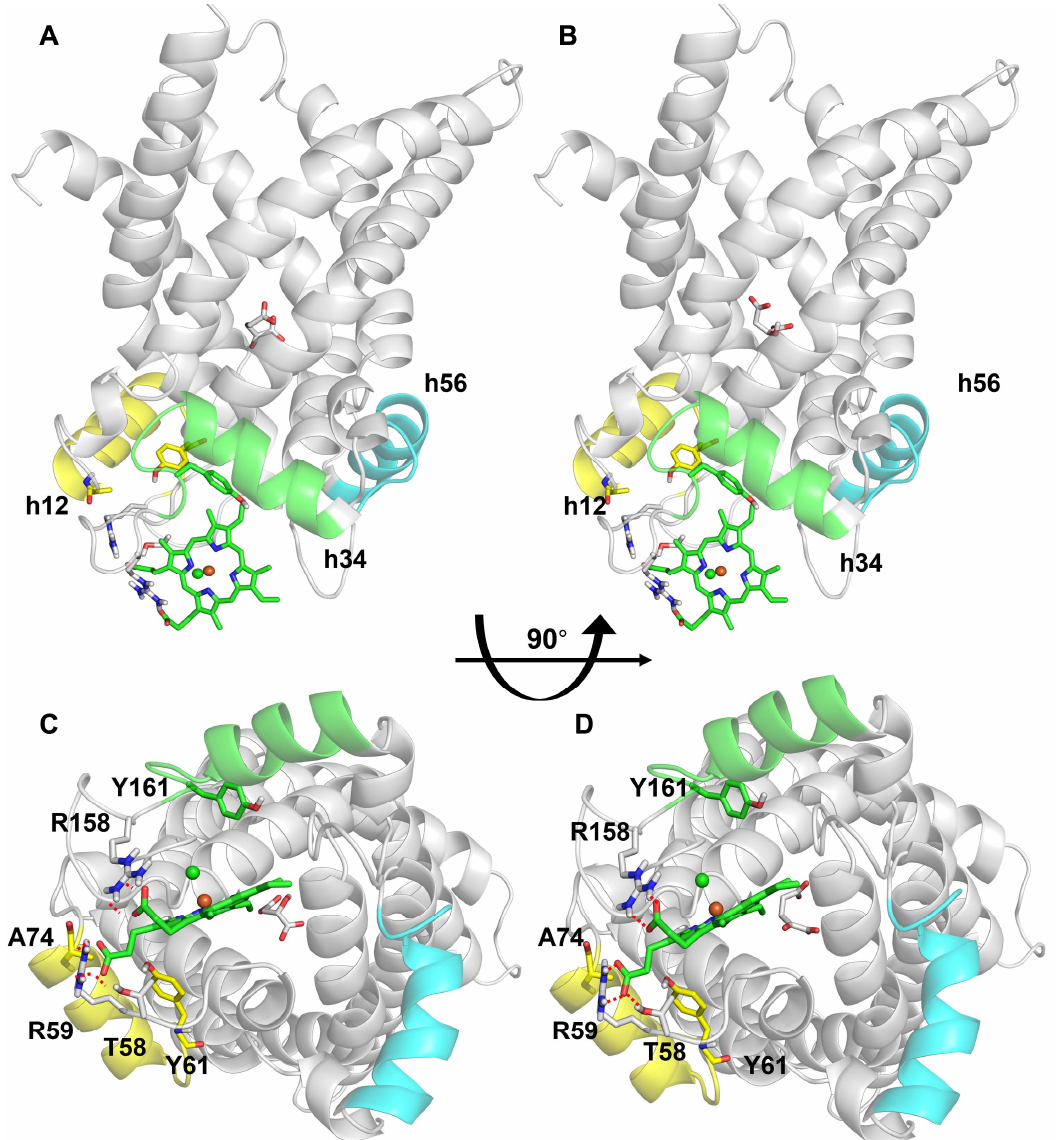
Figure 7. Induced-fit docking results. Panels ( A , B ) report the side view of ternary complexes of OGC–malate–hemin and OGC–2-oxoglutarate-hemin, respectively. The matrix short helices h12, h34, and h56 are colored in yellow, green, and cyan, respectively, and are labeled. Panels ( C , D ) show the bottom views of OGC–malate–hemin and OGC–2-oxoglutarate-hemin ternary complexes, respectively. The best hemin-docked pose produced through IF docking analysis is depicted using green sticks. The red dotted lines indicate hydrogen bonds between hemin and the closest OGC residues among those explored in the docking analyses.